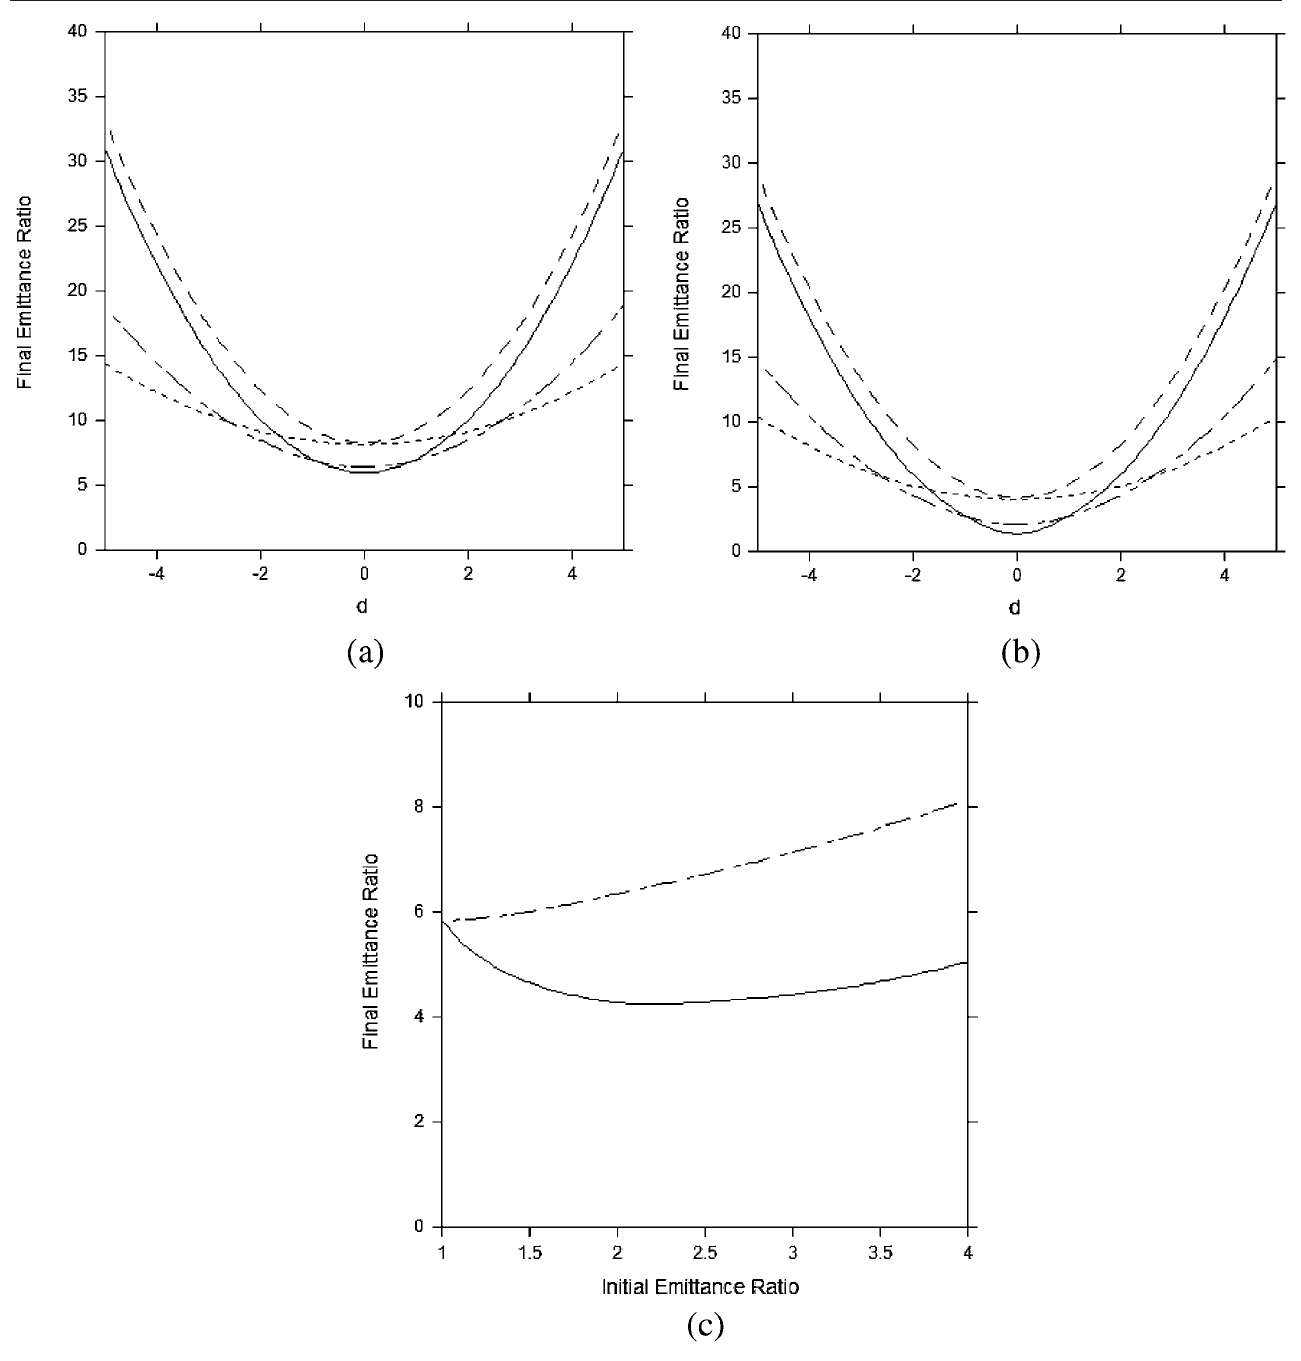
FIG. 2. Numerical modeling of the final emittance ratio for a variety of beam-matrix elements: (a) varying d while setting b ¼ 1 , e ¼ (cid:1) 1 ; (b) varying d while setting b ¼ 1 , e ¼ 1 ; (c) final emittance ratio for a nonsymmetric FBT, varying the initial emittance